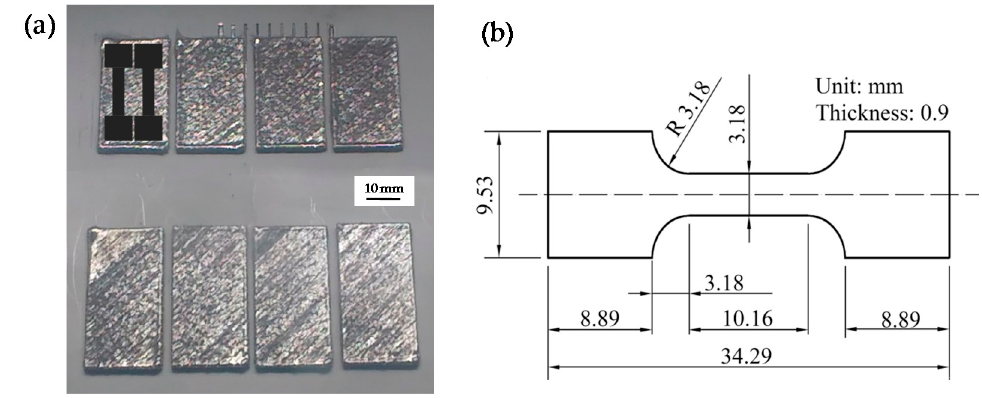
Figure 2. ( a ) The macrograph of the Ti6Al4V samples; ( b ) geometrical shape and size of tensile test specimen. Table 1. The process parameters for the different samples.